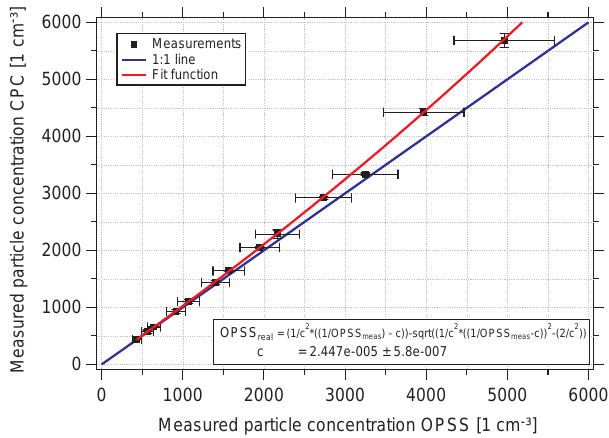
Figure 11. Particle coincidence in the CARIBIC OPSS measured for 200nm PSL